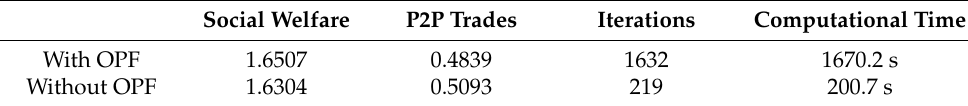
Table 4. ADMM scenarios with and without